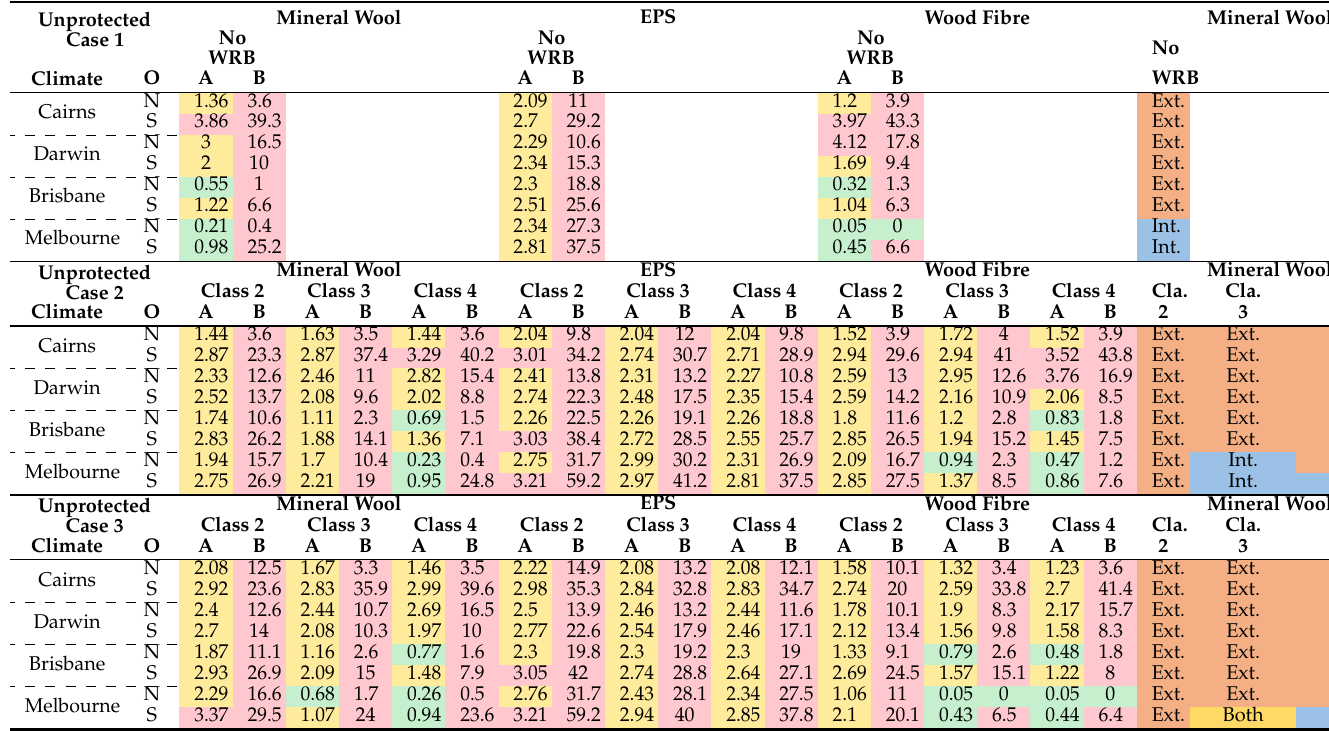
Table A5. Unprotected CLT results for split insulation. O (orientation). Performance criteria: A (mould growth index), B (corrosion rate). Classification of WRB: Class 2, 3, and 4 (vapour permeance). Green (pass), red (fail), or yellow (further investigation). Critical surface that fails the performance criteria indicated in right table: Ext. (external surface), Int. (internal surface), Both (both